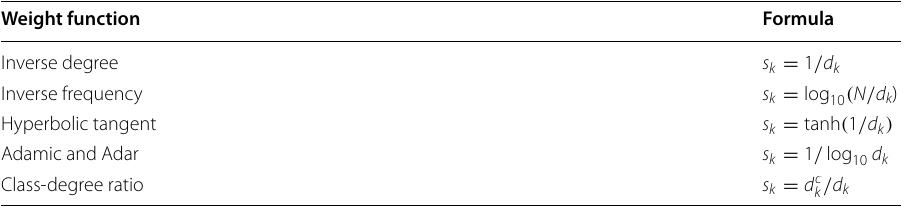
k represents the resource, s k represents the weight of the resource k , d k refers to the degree of the resource k (i.e., the number of links), N represents the number of firms in the network, and d c k refers to the degree of resource k linking to different